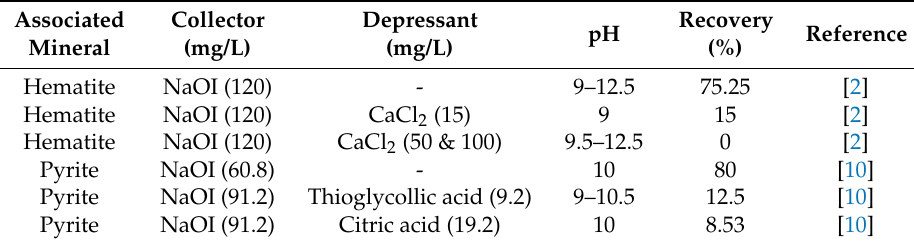
Figure 1. Effect of typical depressants on Mg carbonate flotation in the presence of 60 mg/L NaOI as a collector. Table 4. Effect of depressants on associated minerals of Mg carbonates through flotation separation (in all conditions, dolomite recovery was around 90%).